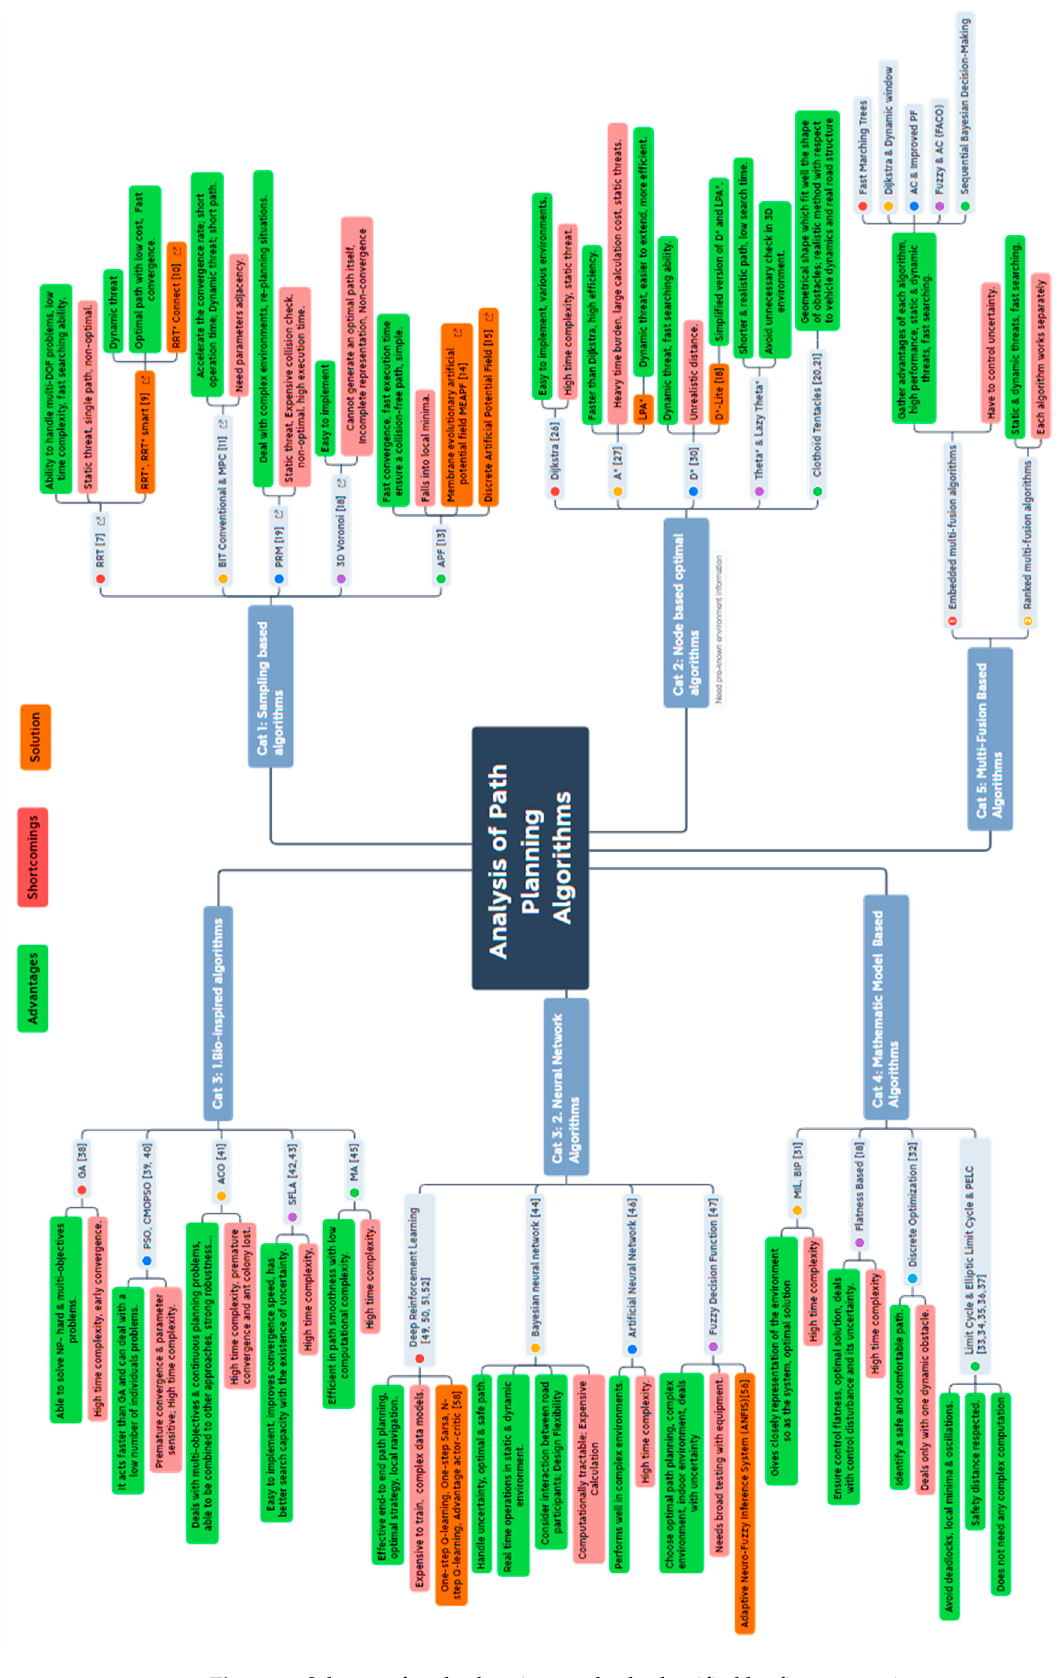
Figure 2. Scheme of path planning methods classified by five categories.